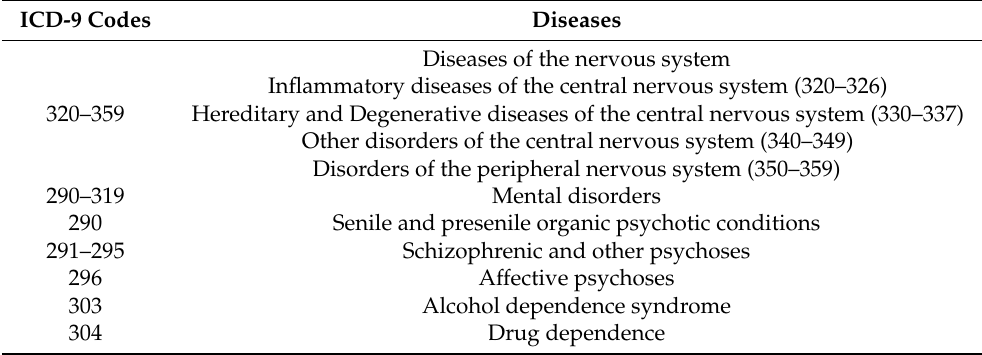
Table 1. International Classification of Diseases, Ninth Revision (ICD-9), codes